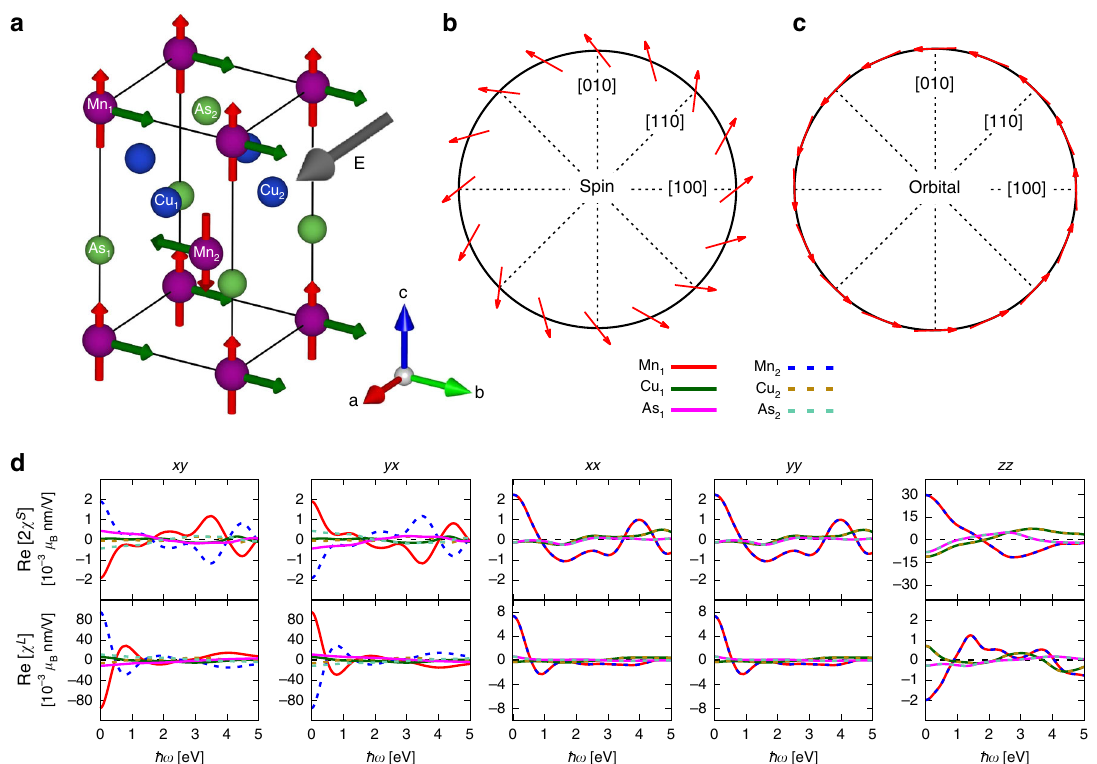
Fig. 1 Magnetization induced by the Rashba-Edelstein effect in antiferromagnetic CuMnAs. a Sketch of the tetragonal unit cell of CuMnAs with the magnetic moments constrained to the c -axis. The inset depicts the direction of the crystal axes. The red arrows on the manganese atoms represent the initial magnetic moments. Applying an electric fi eld E along the (100) direction (gray arrow) induces a nonequilibrium magnetization mainly along the (010) direction (green arrows). b Symmetry of the induced spin magnetization as a function of the static electric- fi eld direction for Mn induced orbital magnetization as a function of the static electric- fi eld direction for Mn 1 . d Real parts of the nonzero tensor components (labeled ij , with i ; j ¼ x , y , or z ) of the spin and orbital Rashba-Edelstein susceptibilities, Re ½ 2 χ S (cid:5) and Re ½ χ L (cid:5) , as function of the electric- fi eld frequency, _ ω